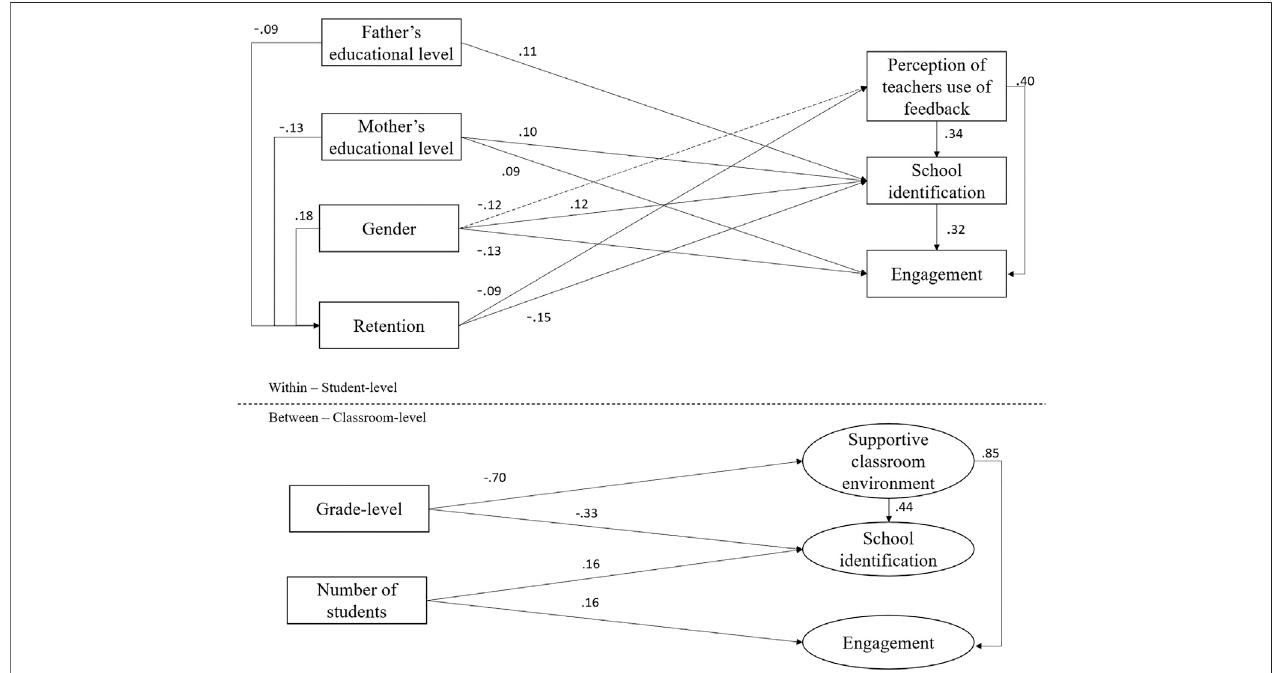
FIGURE 2 | Standardize coefficients of the multilevel Model 2 tested (with MLR estimator). Latent classroom-level constructs are represented as circles and student-level indicators of these latent variables are represented as squares. Dotted lines represent non-signi fi cant